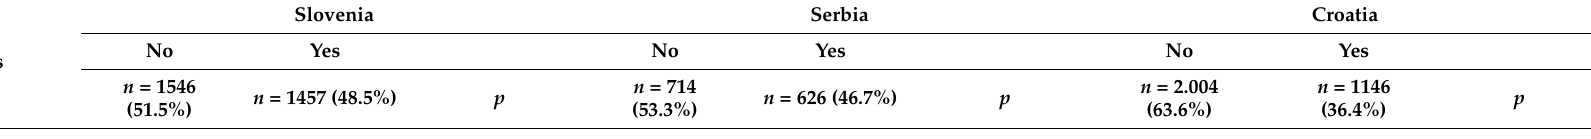
Table 4. Distribution of participants with and without the financial burden of dental care in Slovenia, Serbia, and